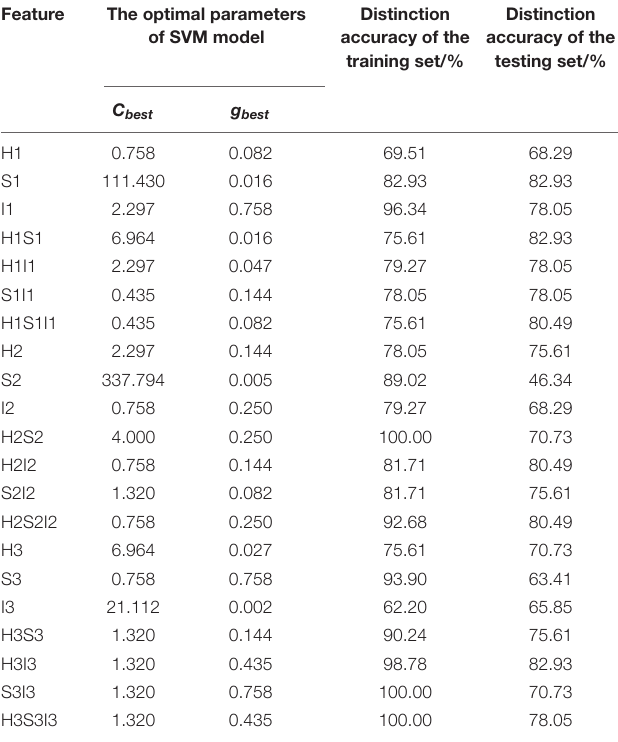
H1 represents the LBP histogram feature of the gray image of the H component of the lesion image filtered by the MB 1 -LBP operator; H2 represents the LBP histogram feature of the gray image of the H component of the lesion image filtered by the MB 2 -LBP operator; H1S1 represents the combination of H1 and S1; the rest features’ implication could be deduced by